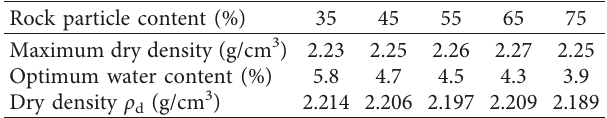
Table 1: Basic parameters of group samples.